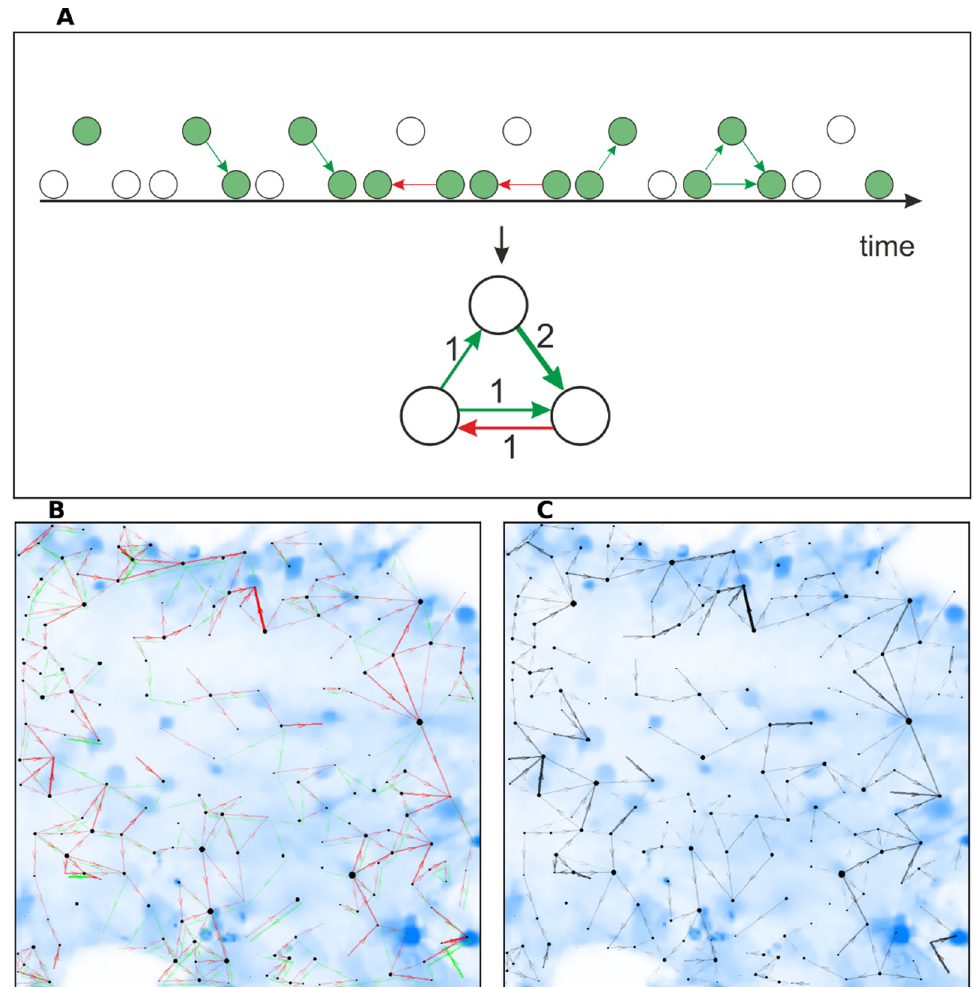
Figure 4. ( A ) Principle of transition to a compressed graph. Example for three adjacent cells for eight consecutive frames. Green and red colors of directed links encoding the direct and reverse transmission between cells (circles). Active cells are shown by the green color filling. Finally, the compressed graph is constructed by counting of directed links (transmissions). Transmission in one direction within several frames is counted only once. The number of transmissions in each direction is counted separately. ( B ) Visualization of a compressed graph. Transmissions in both directions are shown with arrows of different colors (red and green). ( C ) Visualization of a compressed graph. The line contrast increases in proportion to the difference between incoming and outgoing transmissions with arrow in the prevailing direction. The size of the vertices is proportional to the indegree metric, describing the number of incoming edges.